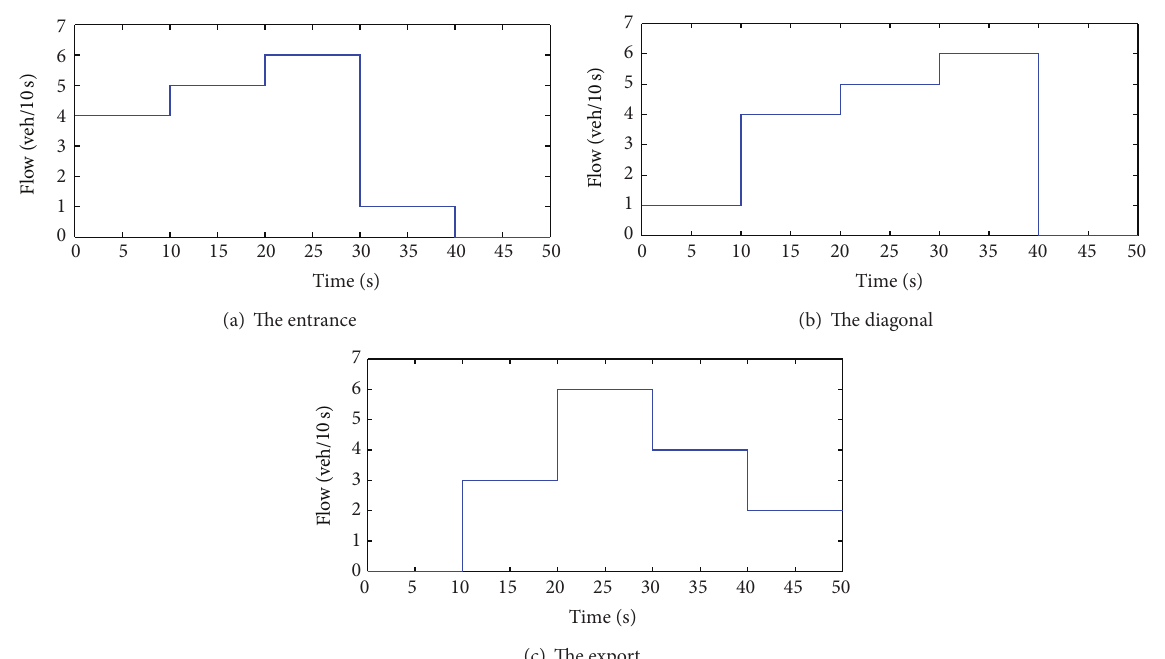
Figure 4: The relationship between flow and time in different